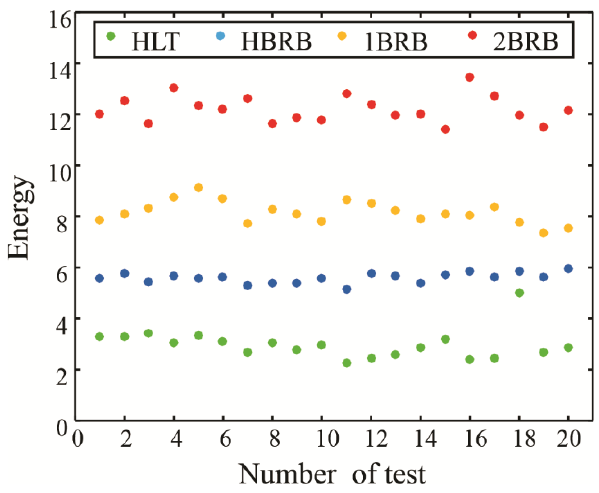
Figure 15. ( a ) Current signal, ( b ) Second extracted component, ( c ) Quantization of the component, ( d ) Upper envelope.